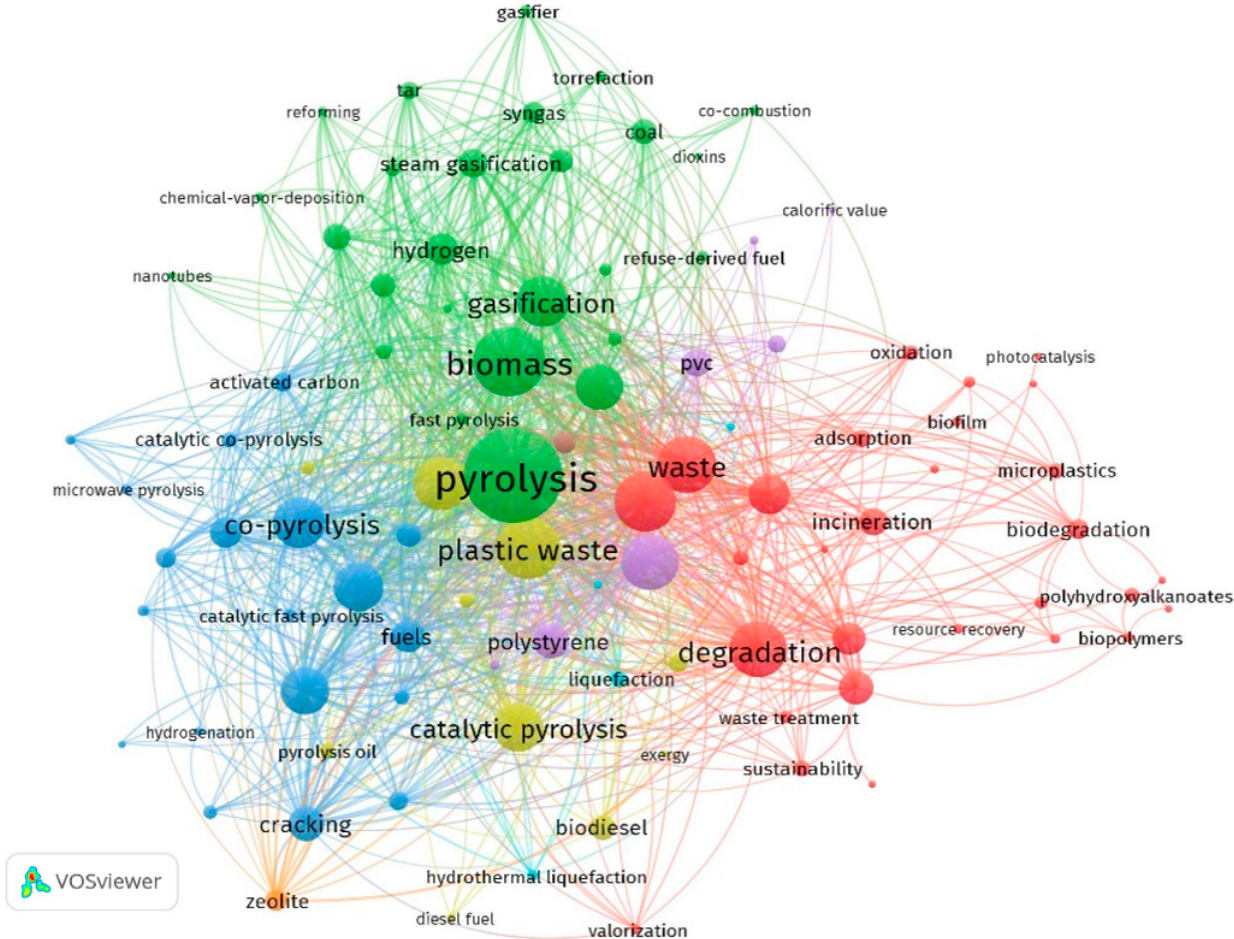
Figure 2. Network map showing co-occurrence of keywords for plastic waste.